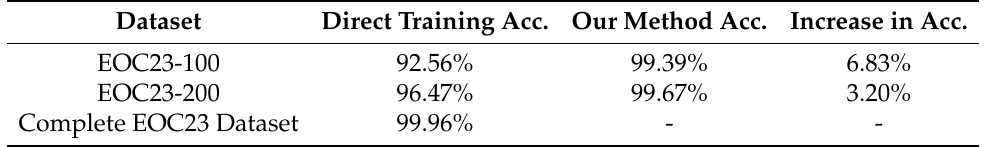
Table 7. EOC2 datasets experimental results.